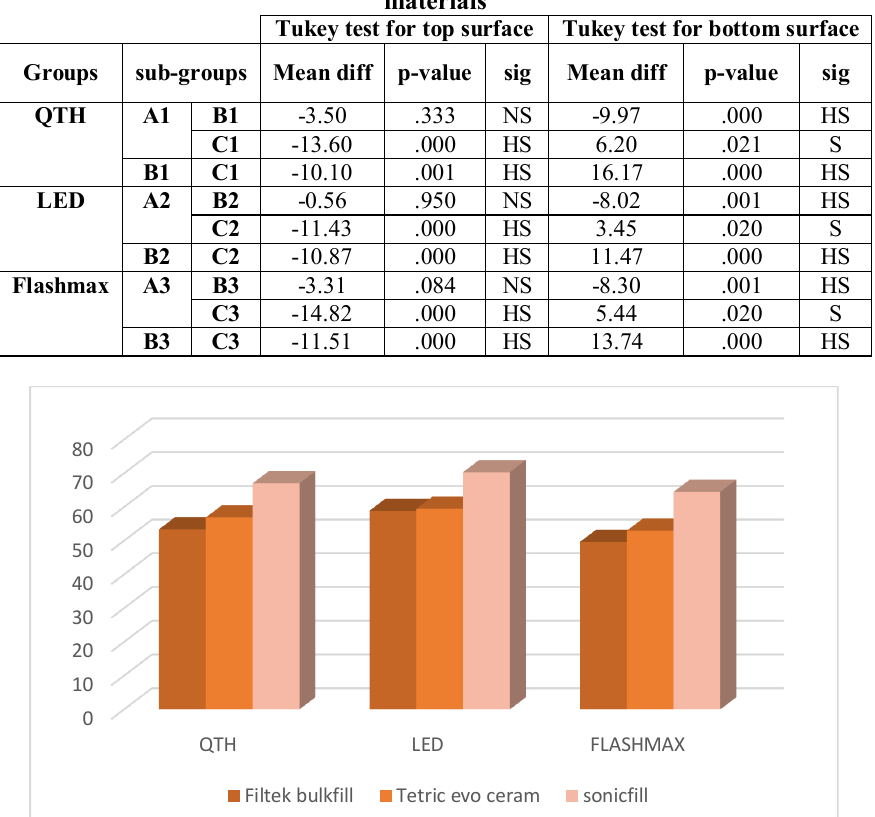
Table 4: Tukey test for the effect of light curing systems on top and bottom surfaces of the tested materials